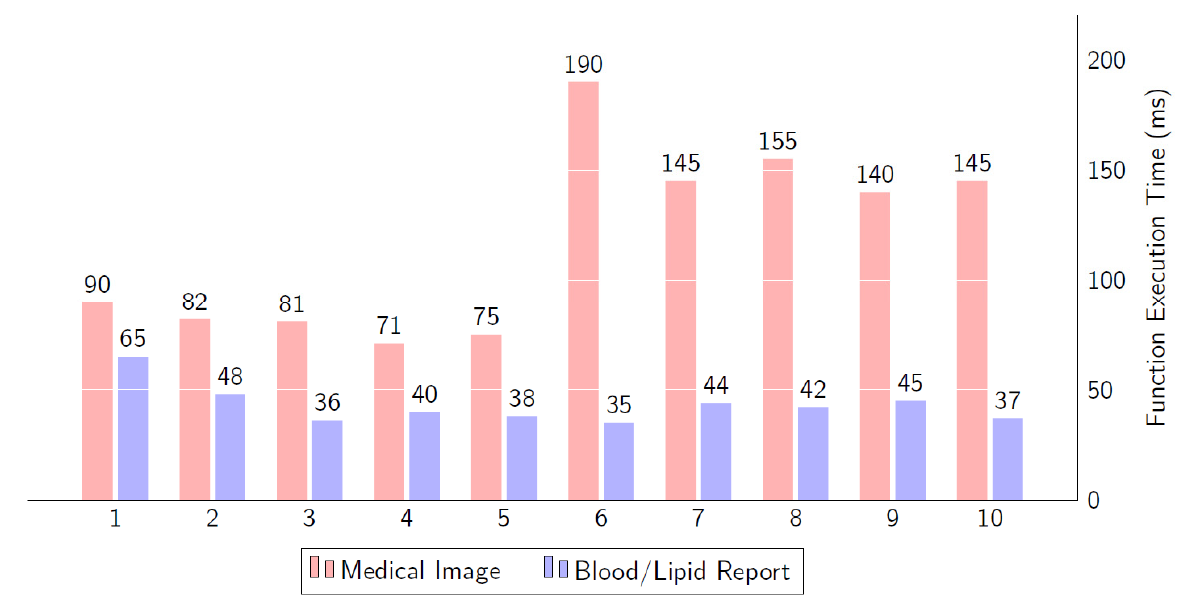
Figure 9. The computational time for function execution to access the data from the IPFS and blockchain.